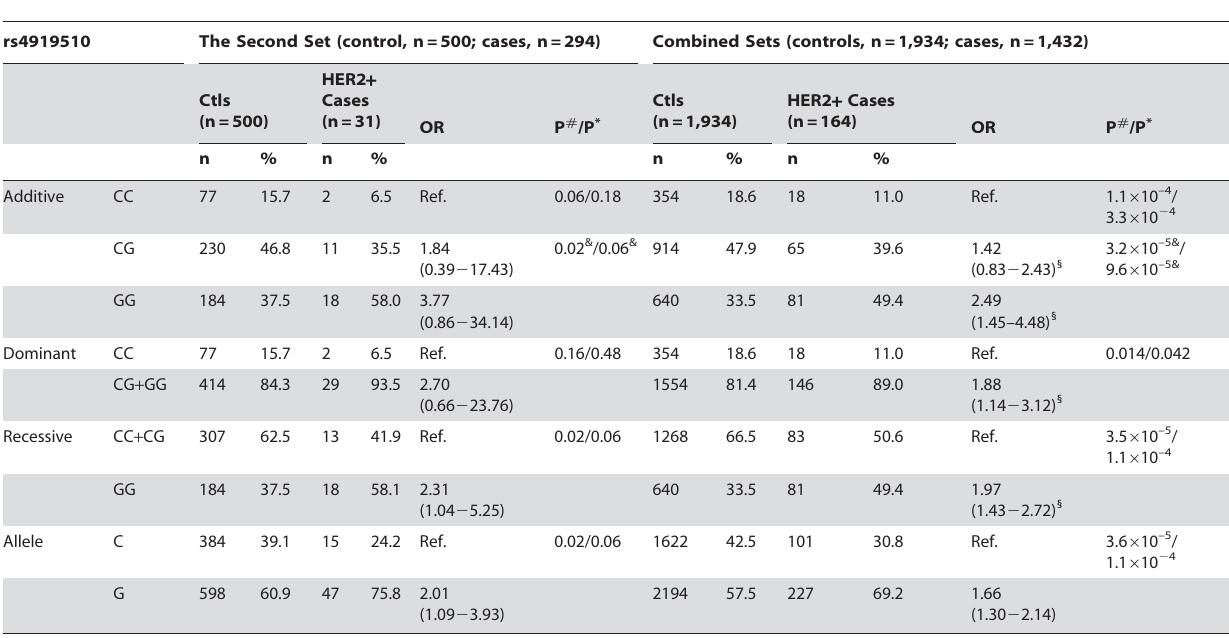
Table 4. Associations between rs4919510:C . G and HER2-positive breast cancer subtype in the IDC cases in combined sets